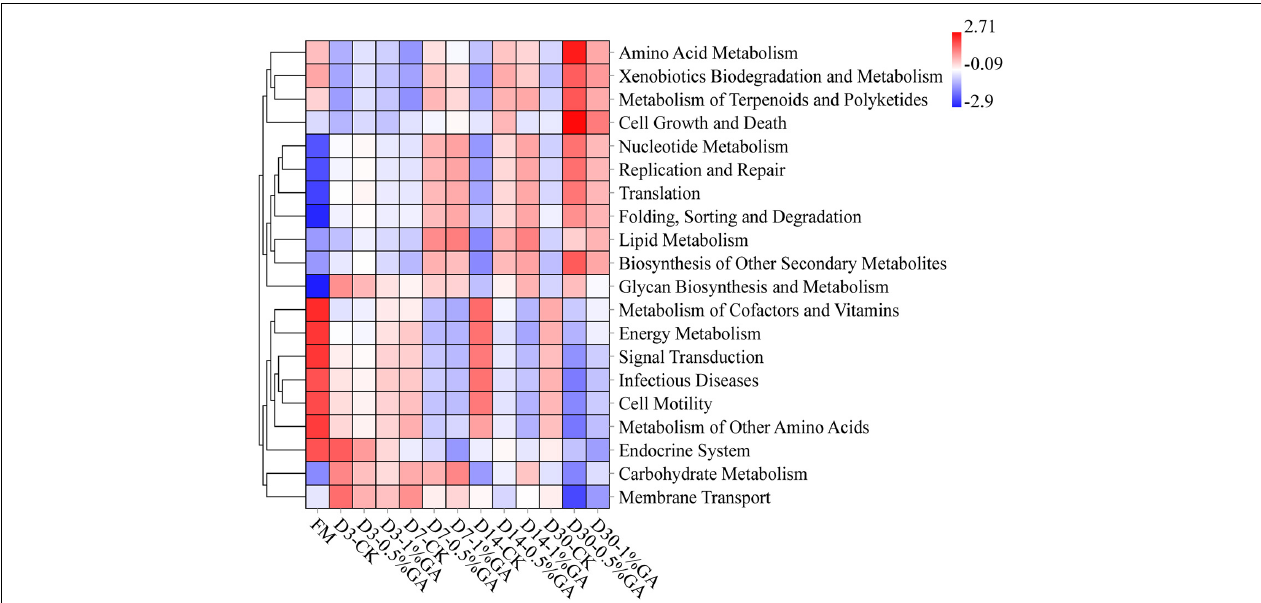
FIGURE 4 | Heatmap of 16S rRNA gene-predicted functional profile for whole plant soybean silage with and without the addition of gallic acid (GA) (FM, fresh matter; CK, blank control; 0.5% GA, 0.5% FM GA addition; 1% GA, 1% FM GA